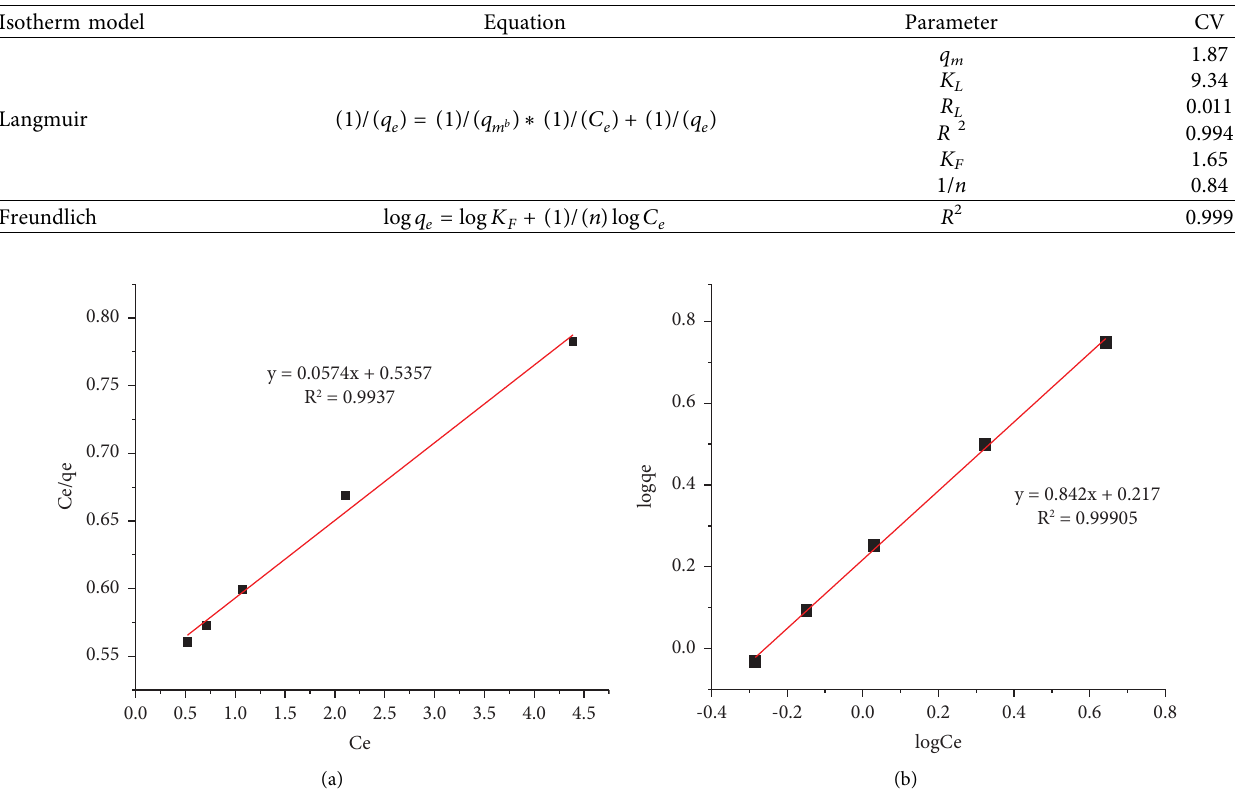
Table 1: Linear sorption isotherm model equation and parameter data.